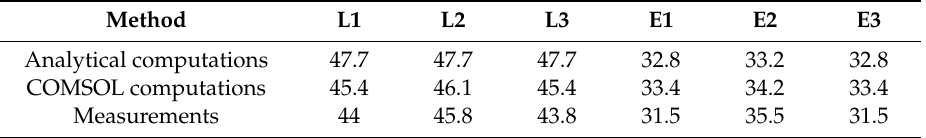
Table 3. Temperature of particular elements in the considered three-phase high-current busduct [ ◦ C].